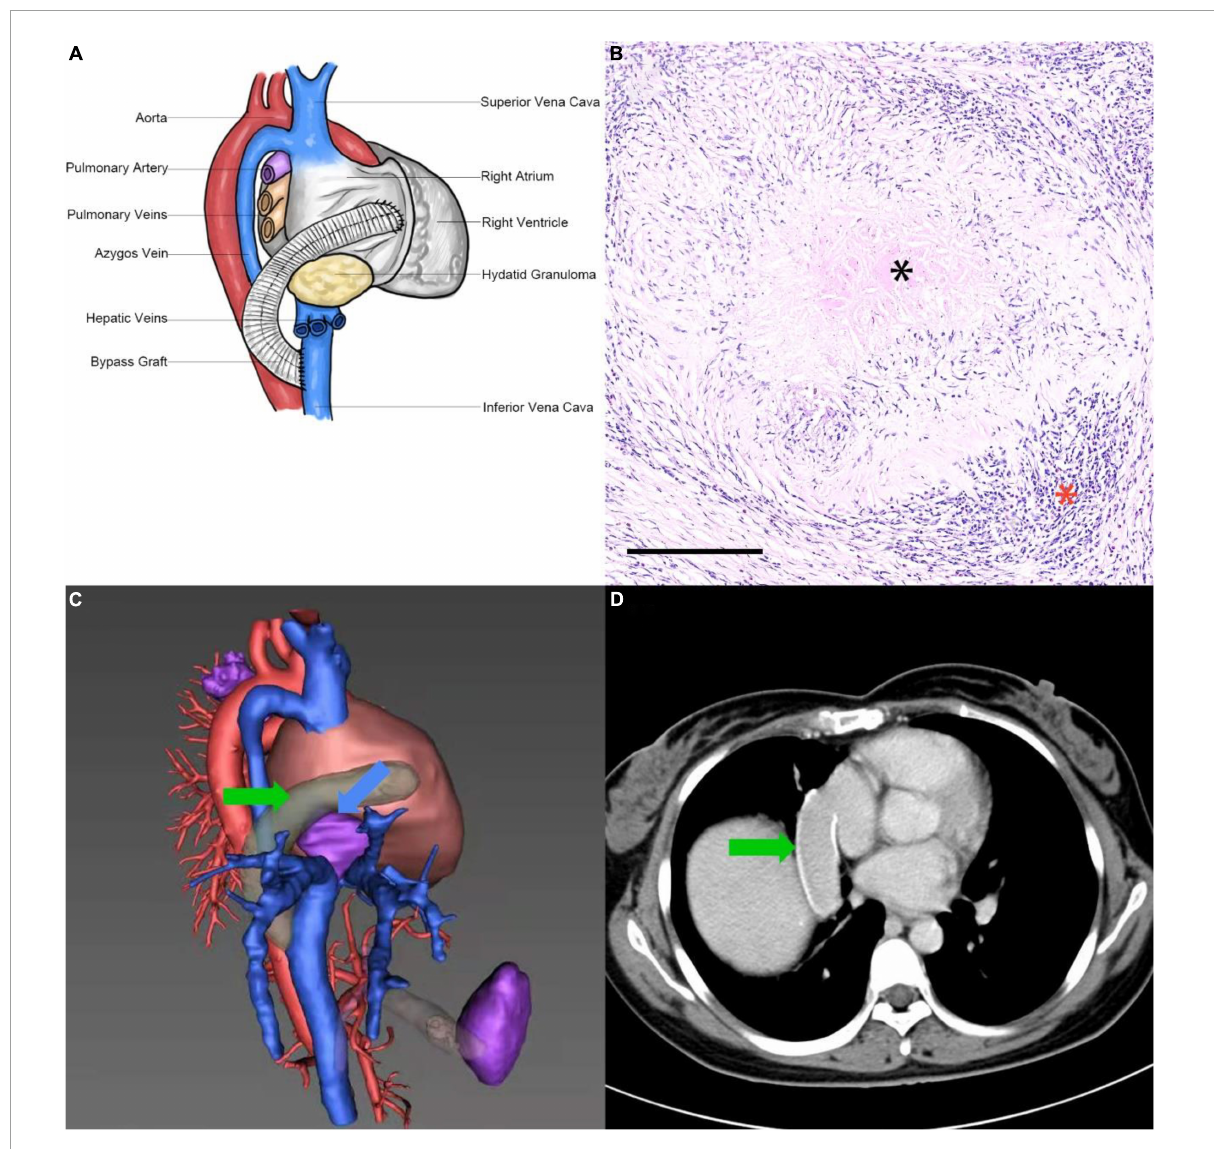
FIGURE2 Surgical technique and postoperative findings. (A) Illustration of the right atrium-IVC bypass. (B) Postoperative pathological analysis showed the existence of cysticercosis (black asterisk), aggregation of eosinophils and proliferation of epithelioid cells (red asterisk). H/E 10 × . The black bar indicates 250 µ m. (C) 3D-reconstruction view of postoperative CTA on 5-year follow-up showed the cardiac mass without enlargement (blue arrow) and vascular graft (green arrow). (D) Postoperative CTA on 5-year follow-up showed the vascular graft remained patent (green